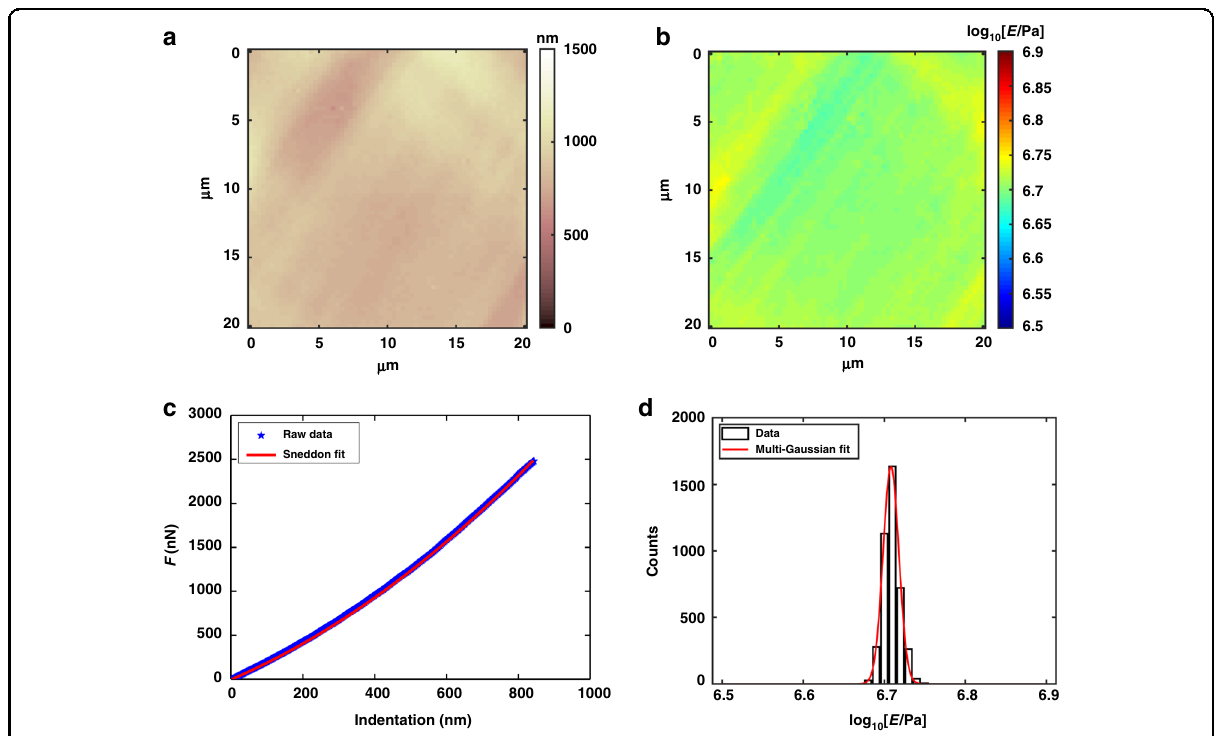
Fig. 7 Graphical results of mechanical analysis by AFM. a Force volume morphology map of PDMS thin fi lm, the color bar indicates height value. b Young ’ s modulus mechanical diagram on a logarithmic scale. c The Young ’ s modulus of the sample was estimated by Sneddon model fi tting based on the force indentation experimental data. d Histograms of Young ’ s modulus values, the red curve is Gaussian fi